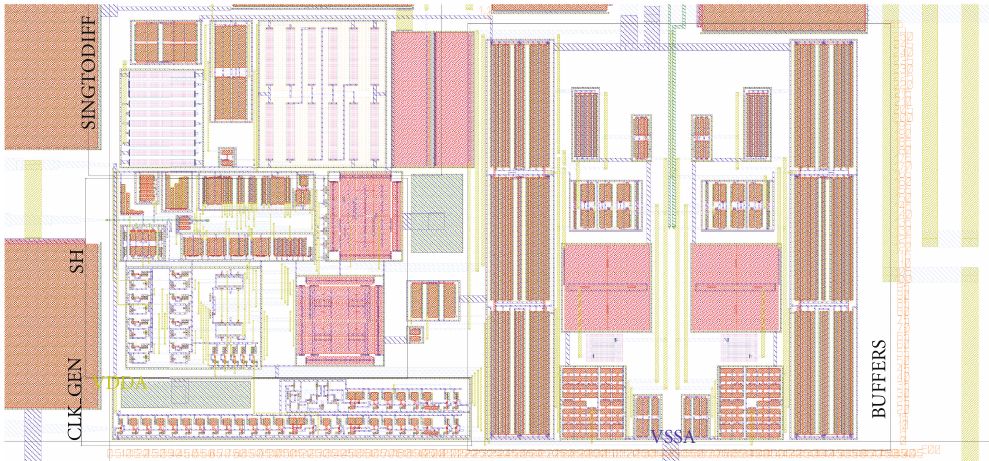
Figure 21: Chip to be fabricated.